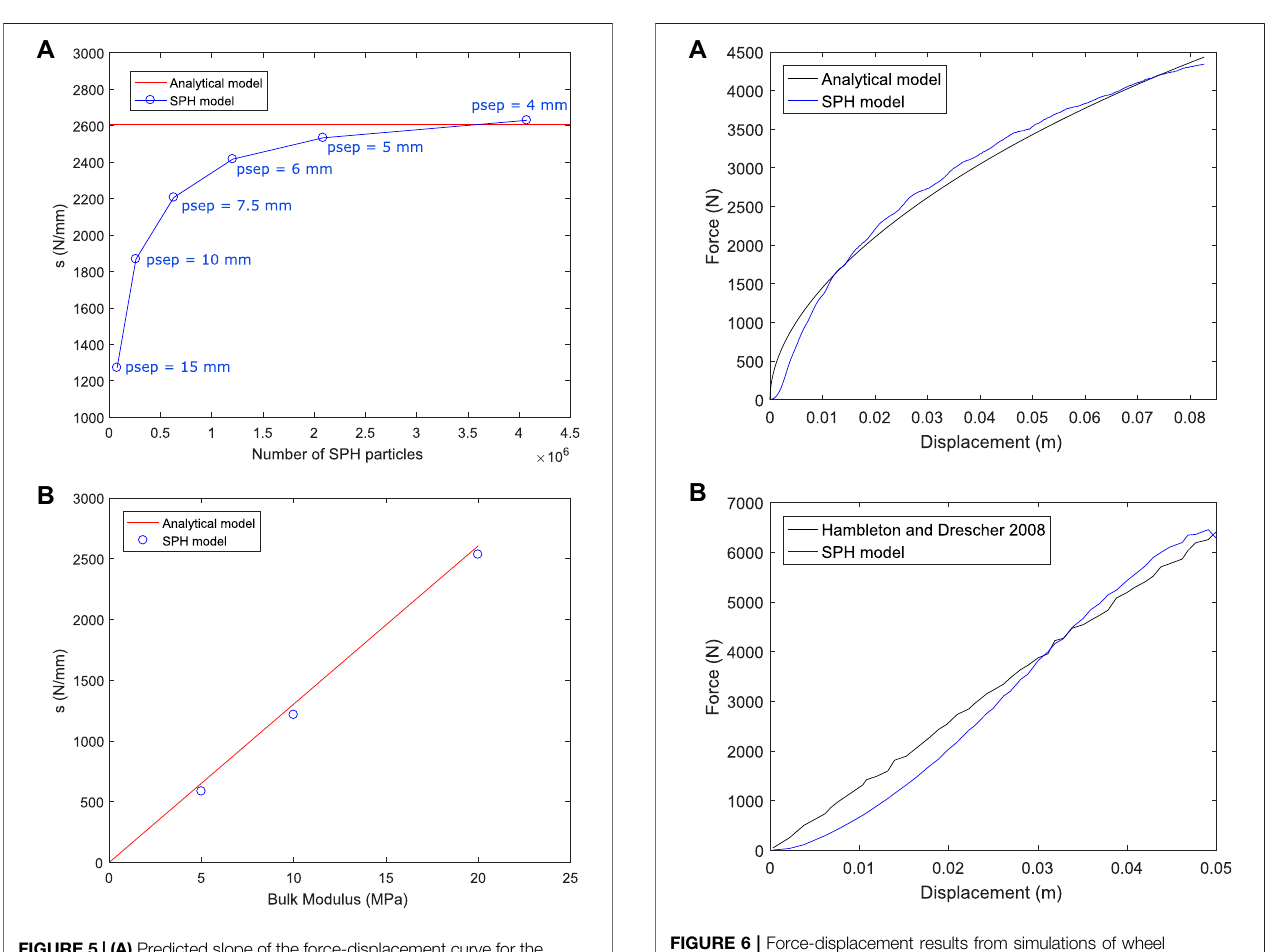
FIGURE 5 | (A) Predicted slope of the force-displacement curve for the cylindrical indentation simulation for different SPH resolutions, compared to the analytical model result. Particle separations (psep) of 4 – 15 mm were used inseparatesimulationsoftheindentationproblem.Thesimulationresults can be considered converged in respect to particle size and veri fi ed against the analytical model for a particle size of 5 mm or smaller. (B) Predicted slope of the force-displacement curve for the cylindrical indentation simulation for differentvaluesofbulkmodulus,comparedtotheanalyticalmodelresultforan SPH resolution of 5 mm.